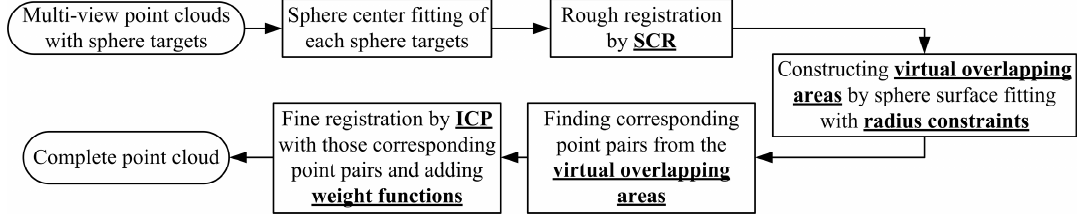
Figure 2. Workflow diagram of the FCR method.